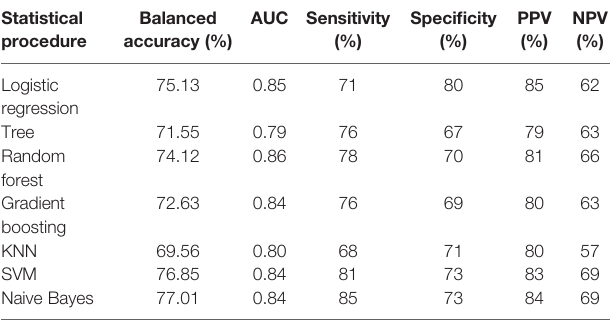
TABLE 2 | Machine learning models and performance during nested